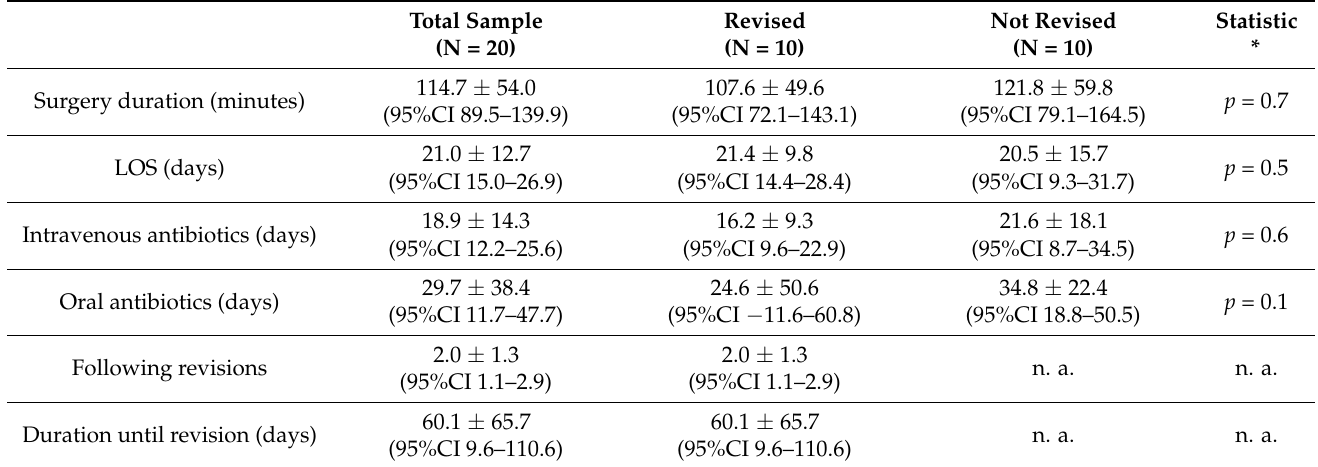
Table 3. Perioperative characteristics of the study